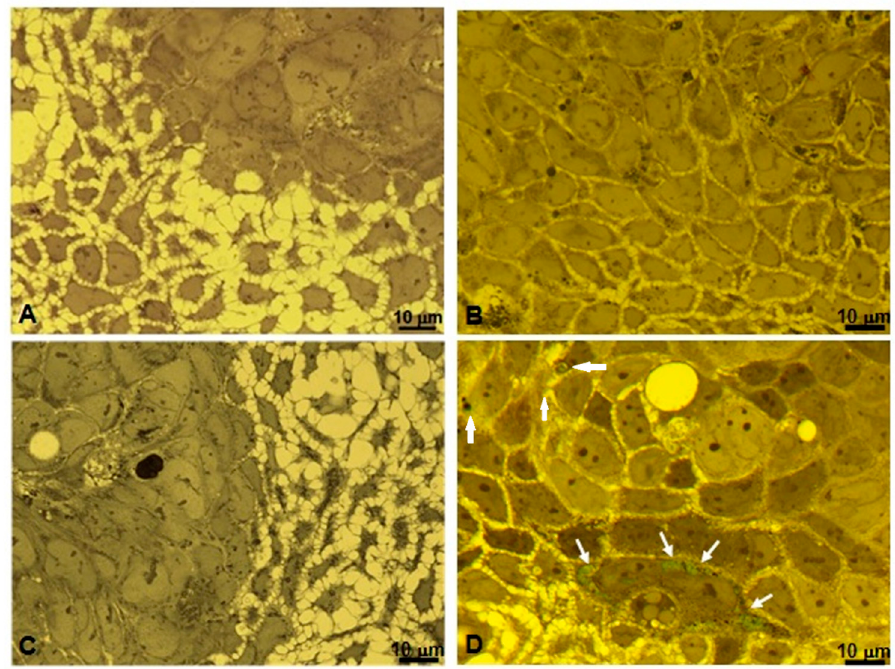
Figure 6. Semithin sections (0.2 µm) of human colorectal adenocarcinoma Caco-2 cell culture stained with toluidine blue and observed through yellow filter in the condenser stage of the light microscope. A ) Untreated cell culture B ) Cell culture treated with unloaded NPs. C ) Cell culture treated with free ICG in water solution. D ) Caco-2 cell culture treated with ICG-NPs1. Green spots are detectable inside